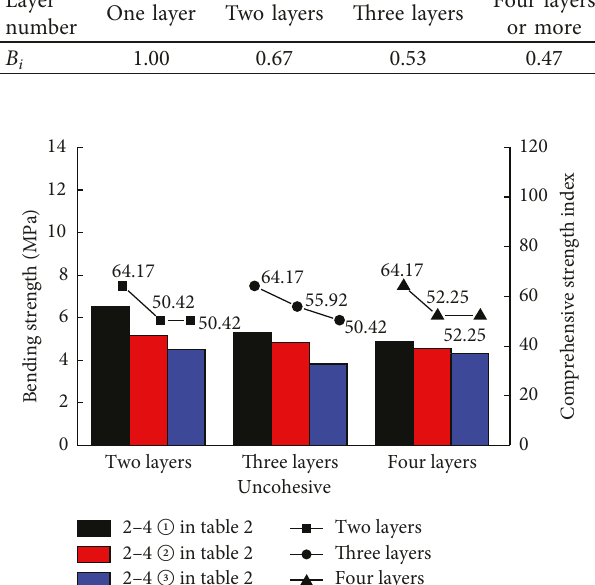
Figure 6: Comparison of bending strengths of combined models at different